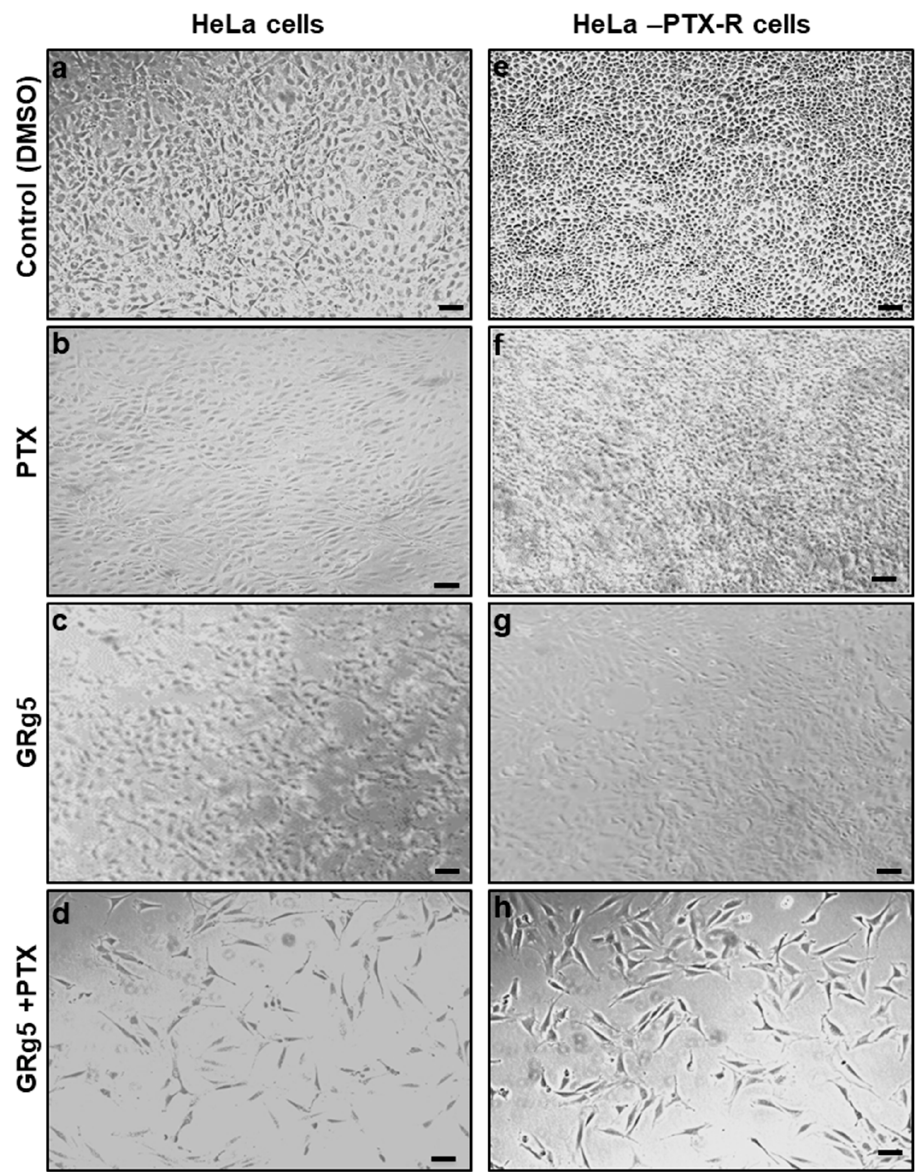
Figure 3. Cytotoxic effects of GRg5 on HeLa and HeLa-PTX-R cells: Representative photomicro- graphs showing morphological changes and cell viability of HeLa naive ( a – d ) and HeLa-PTX-R cells ( e – h ) cervical cancer cells after treatment with GRg5 (20 µ M) only, PTX (4 nM) only or co-treatment with 20 µ M of GRg5 and 4 nM of PTX for 48 h.